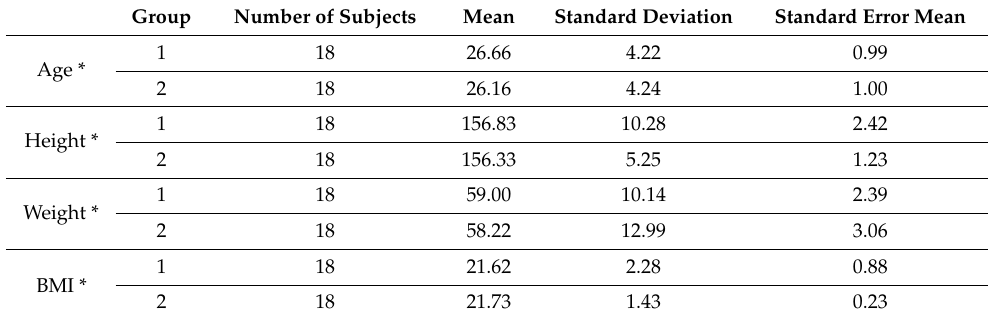
Table 1. Demographic data of all the recruited subjects.